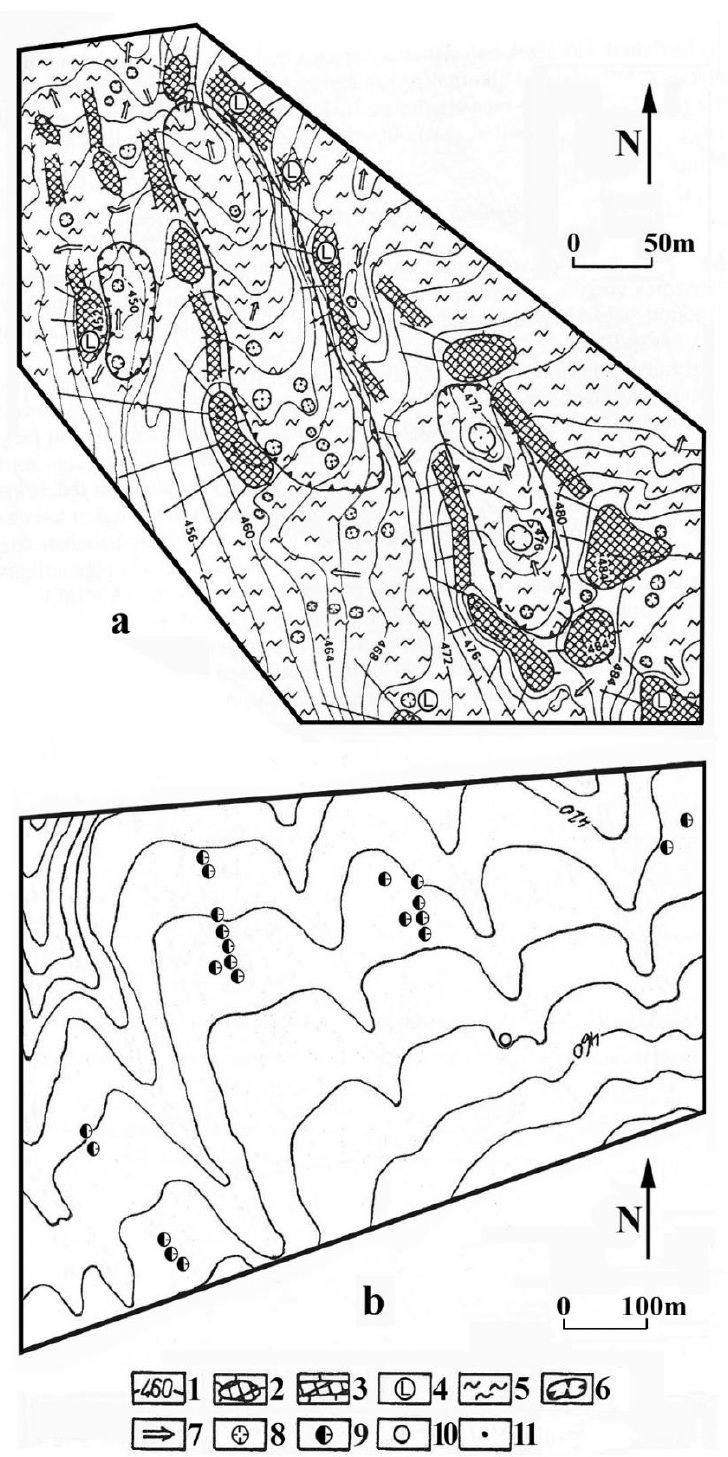
Figure 8. Concealed karst: ( a ) between exhumed limestone mounds from Mester-Hajag (Bakony Region), ( b ) from interfluves from the environs of Márvány Valley (Bakony Region) [63]. Legend: 1. contour line, 2. exhumed mound, 3. semi-exhumed feature (it is ridge-like, but it does not constitute a mound) 4. limestone outcrop on the mound 5. karstifying terrain with superficial deposit between mounds that developed by exhumation, 6. depression of superficial deposit, 7. material redeposition, 8. suffosion doline on the terrain between exhumed limestone mounds, 9. suffosion doline on interfluves, 10. suffosion doline on valley floor, 11. water drainage passage in a karstic depression.